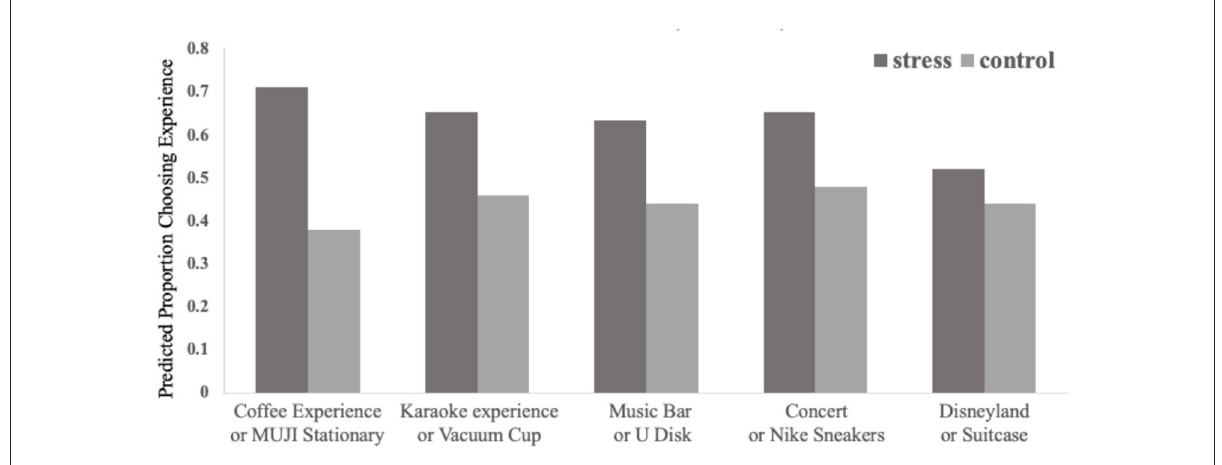
FIGURE2 Proportion of participants choosing the experiential option, across five replicates, by condition (study